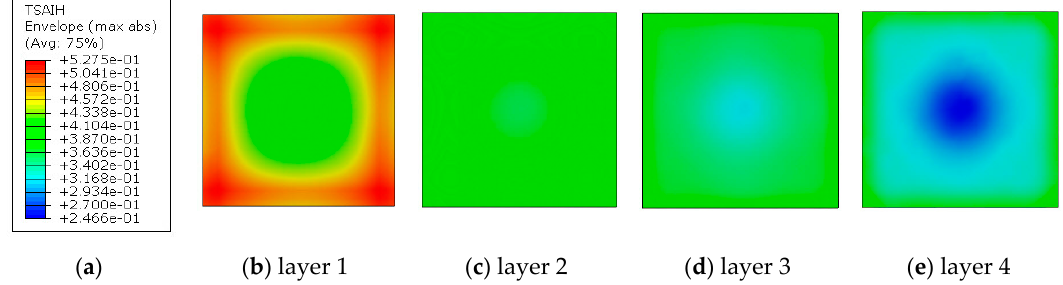
Figure 17. Tsai–Hill criterion for the PMC layers. ( a ) Tsai-Hill criterion ( b ) layer 1 ( c ) layer 2 ( d ) layer 3 ( e ) layer 4.